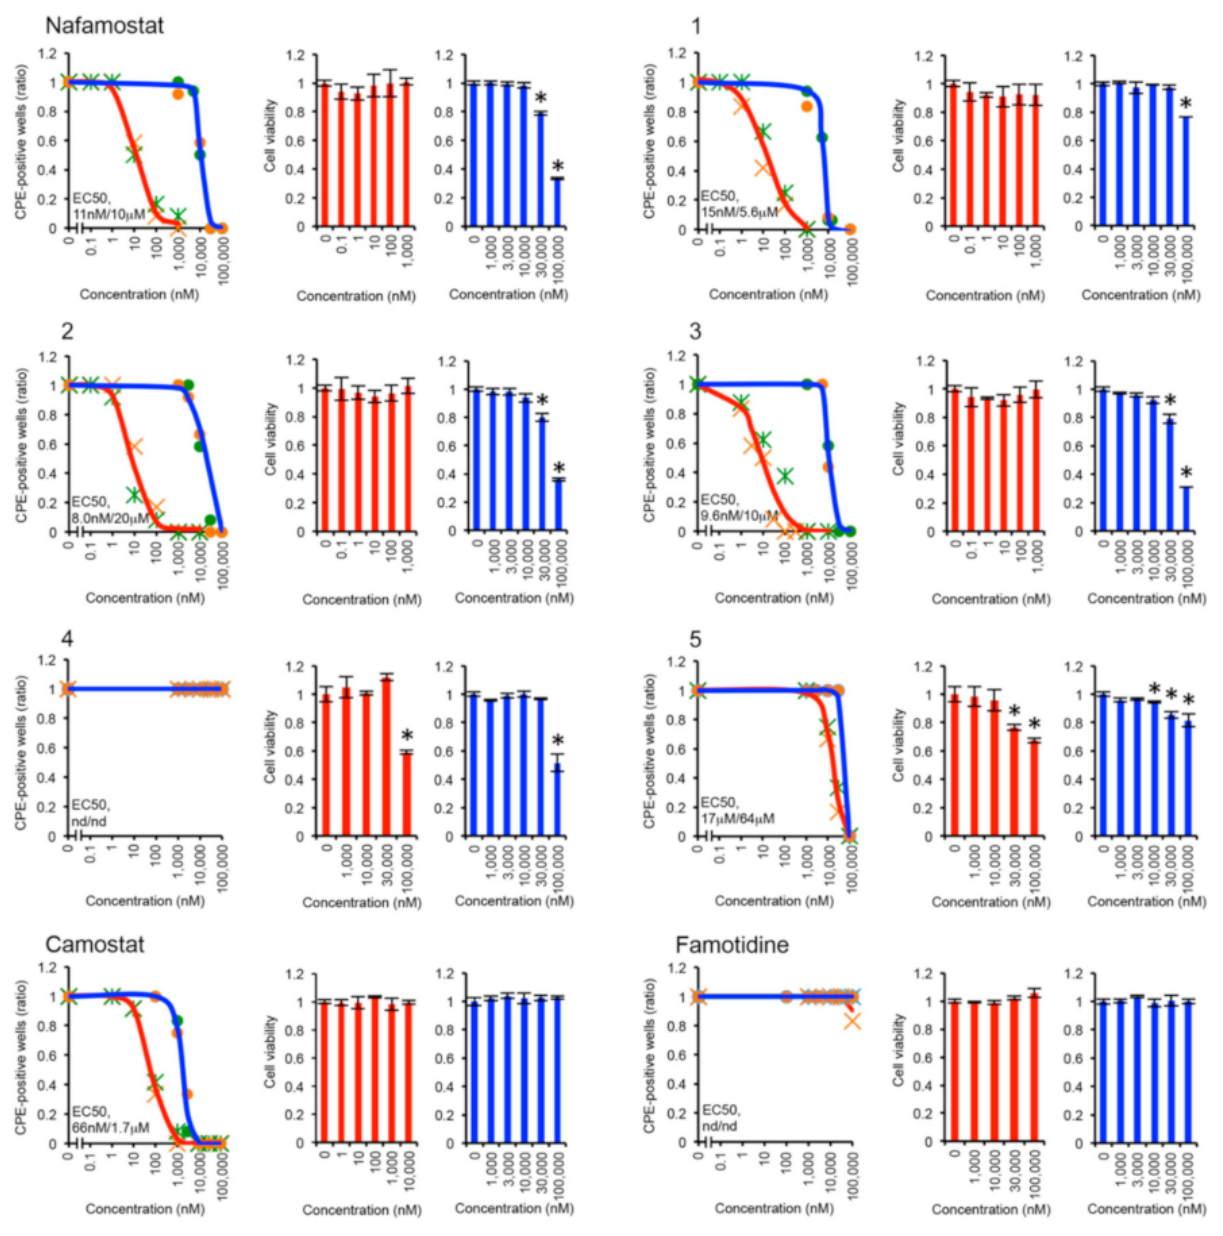
Figure 4. Antiviral effect of possible TMPRSS2 inhibitors (line charts). For “medium change (red lines)” condition, Calu-3 cells on 96-well plates were pre-treated with various concentrations of inhibitors for 1 h, and then infected with SARS-CoV-2 at low multiplicity of infection (MOI) for 30 min, followed by media change. Note that inhibitors were continuously added until the end. For “no medium change condition (blue lines)”, Calu-3 cells were treated likewise, except that media were not changed after infection. After 5 days, numbers of cytopathic effect (CPE)-positive wells were counted and EC50 was determined. Two independent experiments were performed for each condition and the ratios of CPE-positive wells are plotted as green or orange markers. MTS assay was also carried out to evaluate the effect of inhibitors on cell viability (bar charts). For this purpose, cells were treated in the similar fashion under “medium change (red bars)” and “no medium change (blue bars)” conditions, but the virus was not inoculated. Three independent experiments were performed for each condition, and the mean ± SD are shown. An asterisk indicates p < 0.005 by Student’s t